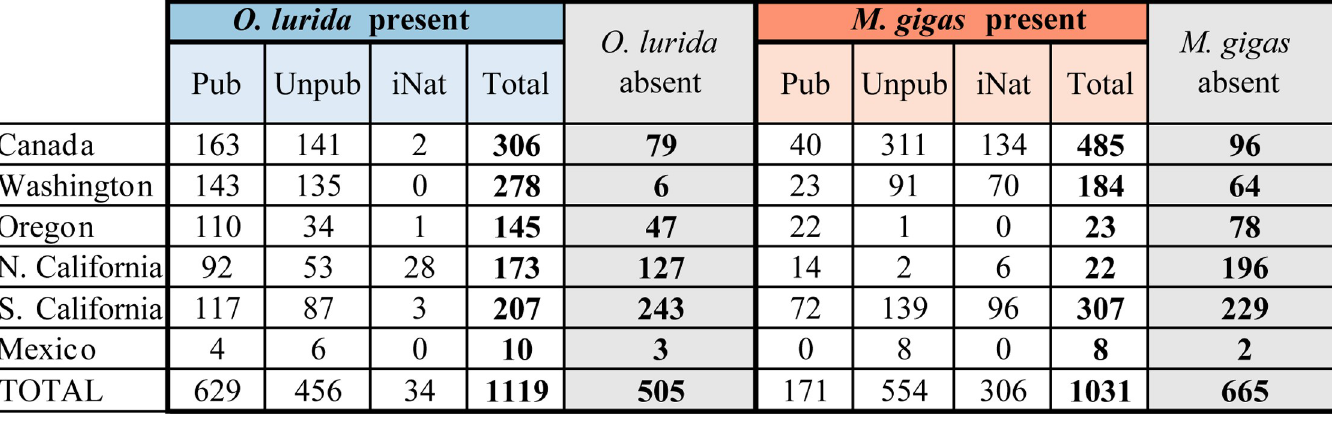
Fig 4. Summary of oyster records. This table shows the number of records by presence/absence, region, and publication type for O . lurida and M . gigas . Grey columns indicate total records by region. Note that individual records sometimes contain data for both species, meaning the total sums of records by species exceed the total number of records collected. Abbreviations: Pub = Published, Unpub = Unpublished, iNat = iNaturalist.